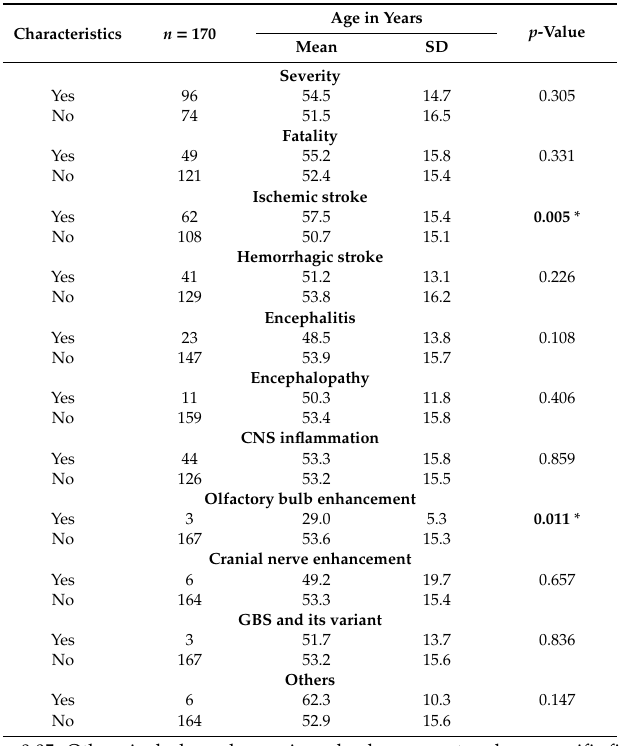
Table 3. Age distributions of all COVID-19 patients based on neurological diagnoses through MRI